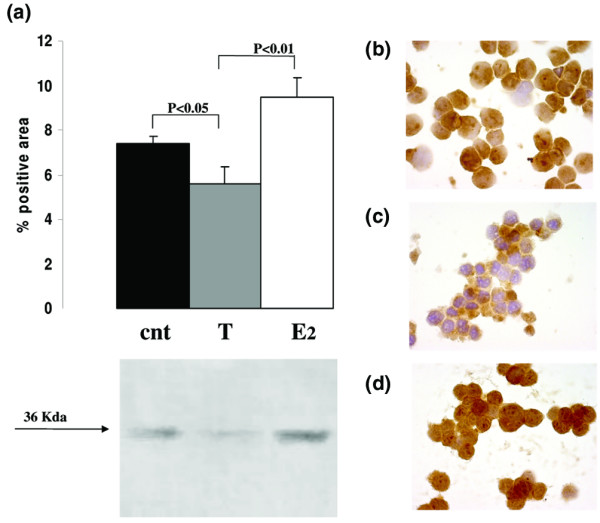
Proliferating cell nuclear antigen (PCNA) expression in cultured human THP-1 cell line. (a) Proliferating cell nuclear antigen (PCNA) expression in the cultured human THP-1 cell line after hormonal treatment. Results are expressed as the mean ± standard deviation of the percentage of staining area (positive area defined as the number of pixels detectable per micron square) for 100 cells in five different experiments. Bottom: western blot analysis. (b) PCNA expression in untreated THP-1 cells (control [cnt]). (c) PCNA expression in THP-1 cells treated with testosterone (T) after 168 hours. (d) PCNA expression in THP-1 cells treated with 17β-oestradiol (E2) after 168 hours (magnification, × 500).